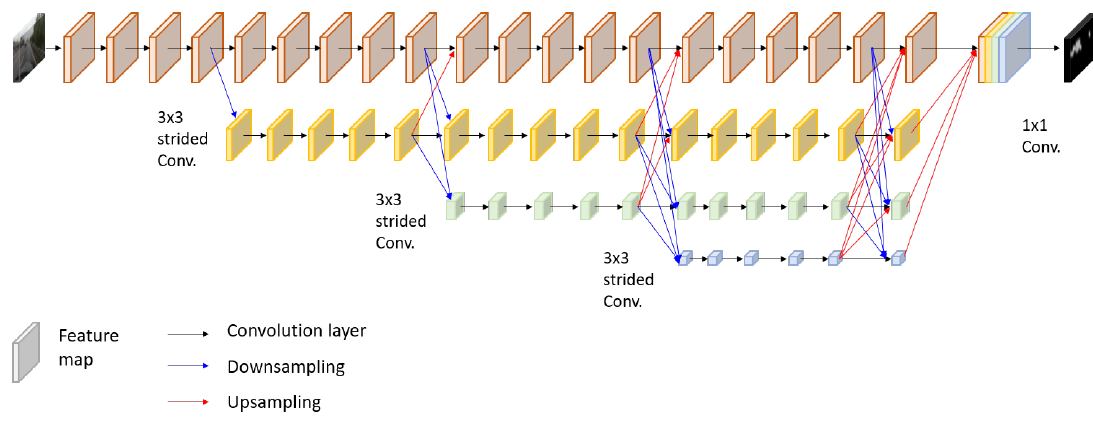
Figure 4. Network architecture. There are four sequential sub-networks that represent features at different resolutions. Black, blue, and red arrows denote convolution layer, downsampling layer, and upsampling layer,